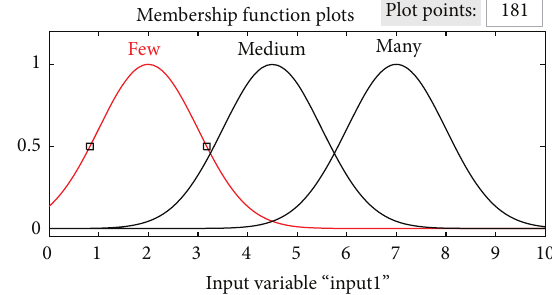
Figure 3: Membership functions of the inputs of FLC.